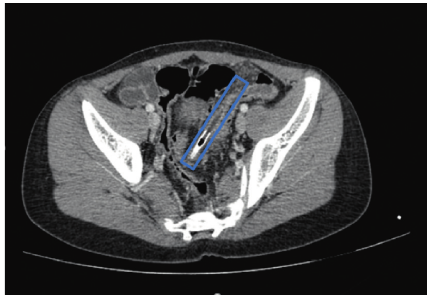
Figure 1: Computed tomography imaging of a 14-year-old boy with evidence of a foreign body (paintbrush) in the pelvic cavity, anterior to sigmoid bowel loops (marked with blue outline).